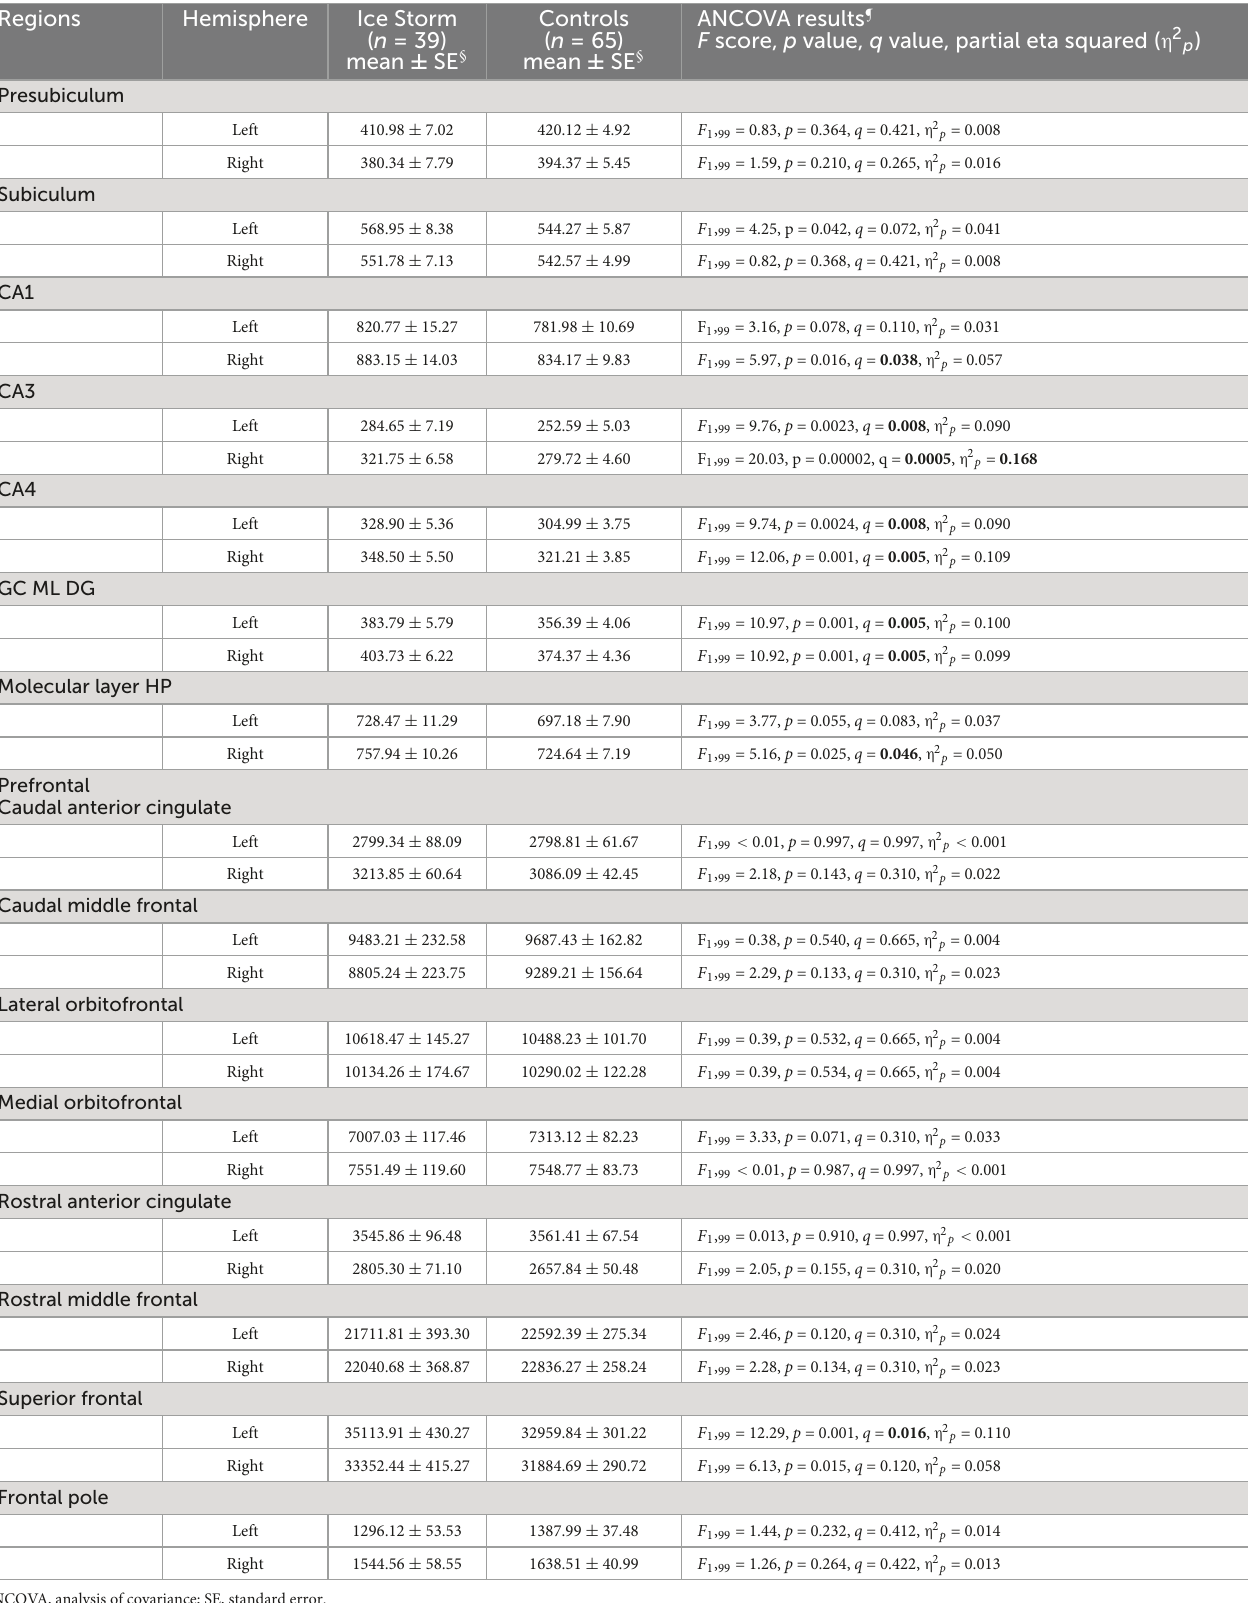
ANCOVA,analysisofcovariance;SE,standarderror. § MarginalmeanandSEwithcontrollingforT1wRepetitionTime(TR),EchoTime(TE),andsex. ¶ Between-groupdifferencewithcontrollingforT1w,TR,TE,andsex. Bold p valuesindicatesignificantresultsforthewholeamygdalaandthewholehippocampus. Bold q values indicate significant results at FDR-corrected threshold for 18 comparisons based on 9 amygdala nuclei (left and right), 24 comparisons based on 12 hippocampal subfields (left and right),16comparisonsbasedon8prefrontalsubregions(leftandright). Bold η 2 p valuesindicatelargeeffectsize( >